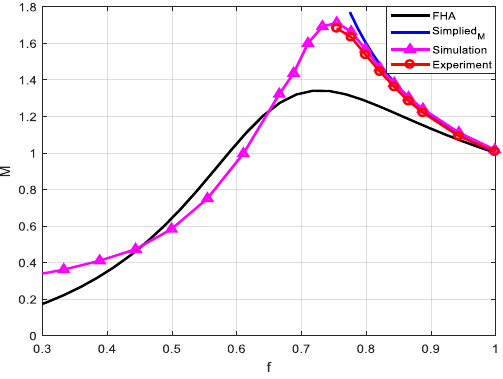
Figure 16. Gain curve comparison. FHA = fundamental harmonic approximation.